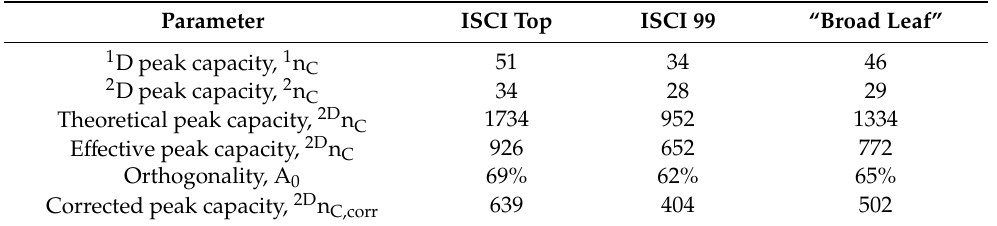
Table 2. Peak capacity and orthogonality values for the RP-LC × RP-LC analysis of the three Brassica juncea extracts. Parameter ISCI Top ISCI 99 “Broad